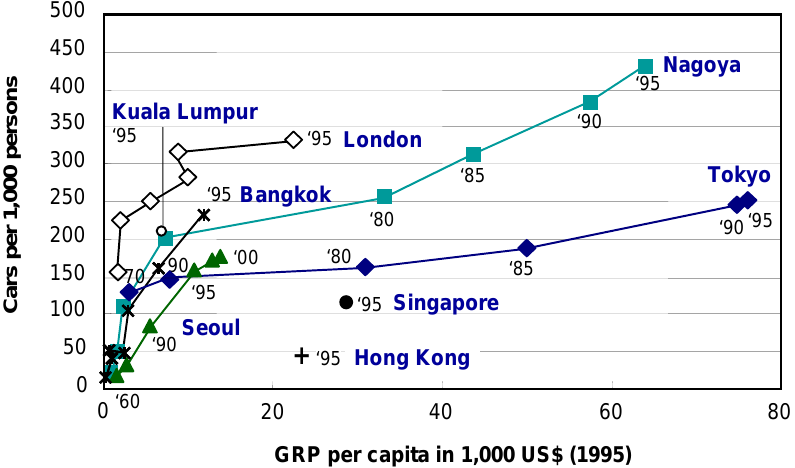
Figure 1. Recent trends of motorisation in selected Asian